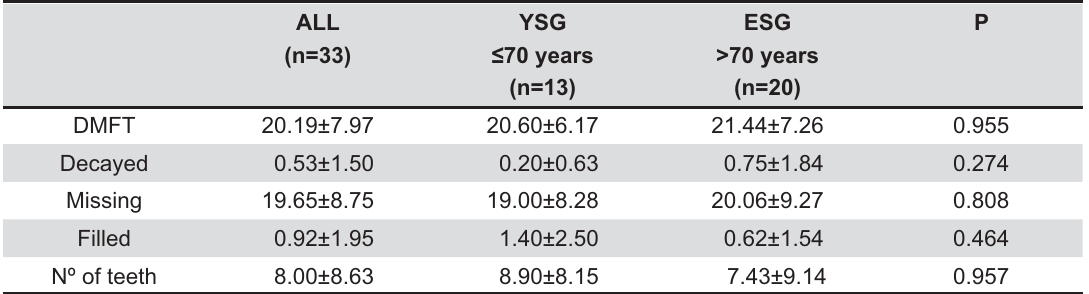
Table 1- Distribution of the sample in the Young Senior Group (YSG), with age equal to or less than 70 years, and the Elderly Senior Group (ESG), aged more than 70 years, by the DMFT index. (Results are mean±standard